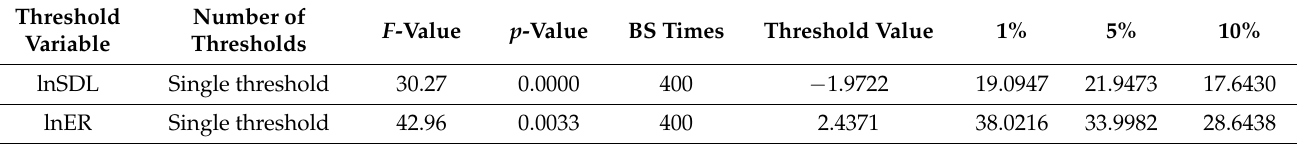
Table 4. Analysis results of threshold existence test.